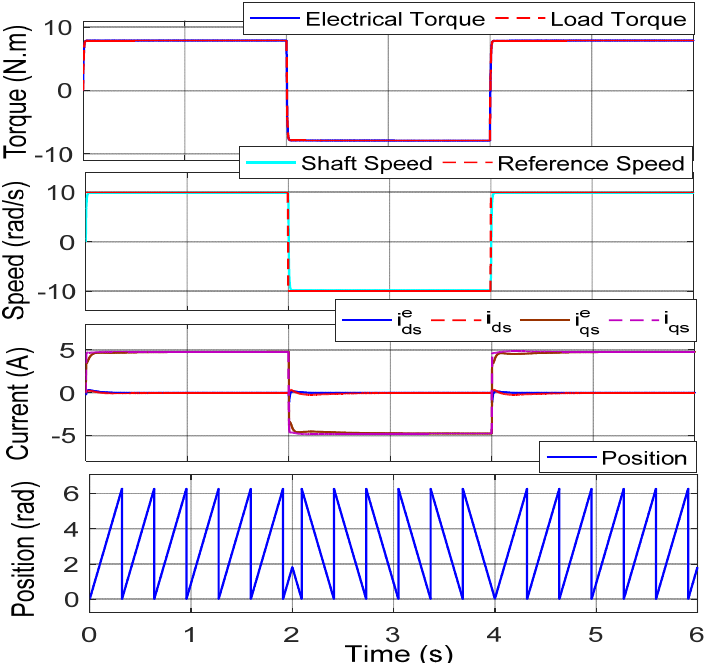
Figure 6. The drive was tested for the forward motoring and reverse motoring operations for the ramp step commands